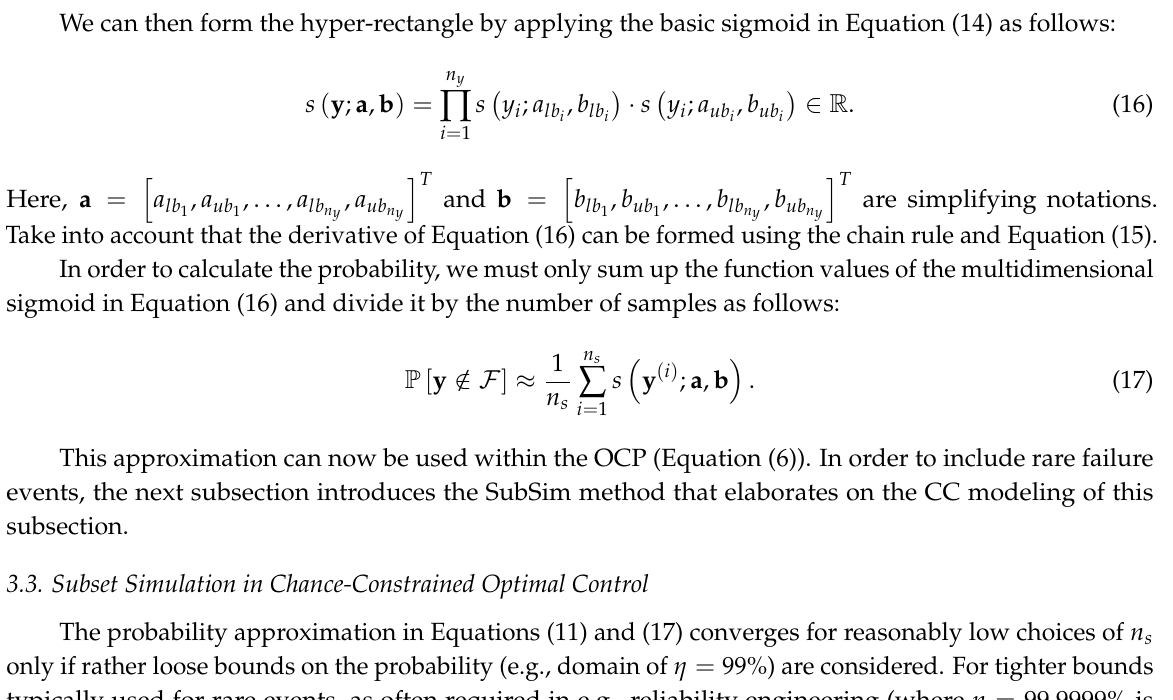
Figure 1. Product of two sigmoids with different scaling and offset parameters to approximate an uncertainty domain by box